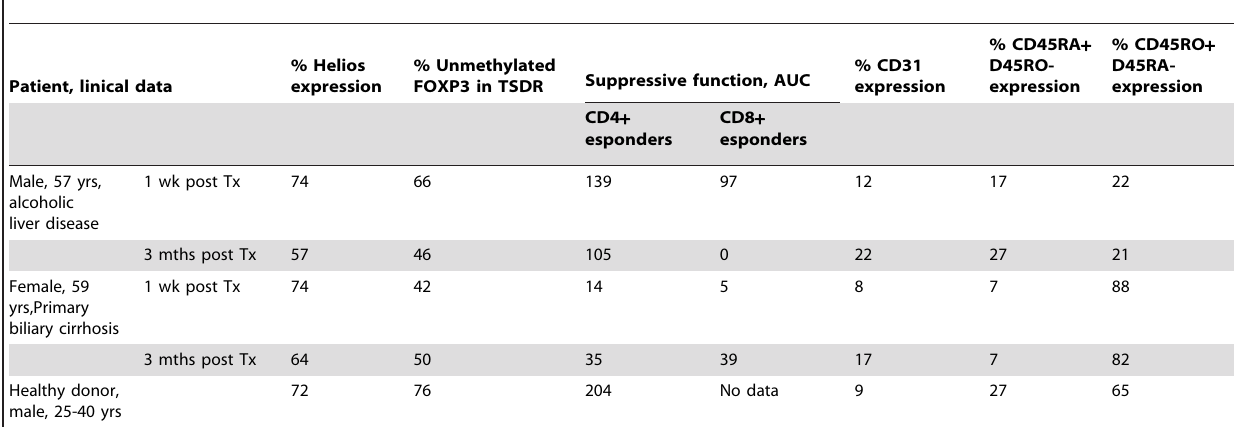
Table 3. Helios expression, FOXP3 demethylation, maturation phenotype and Treg suppressive function.